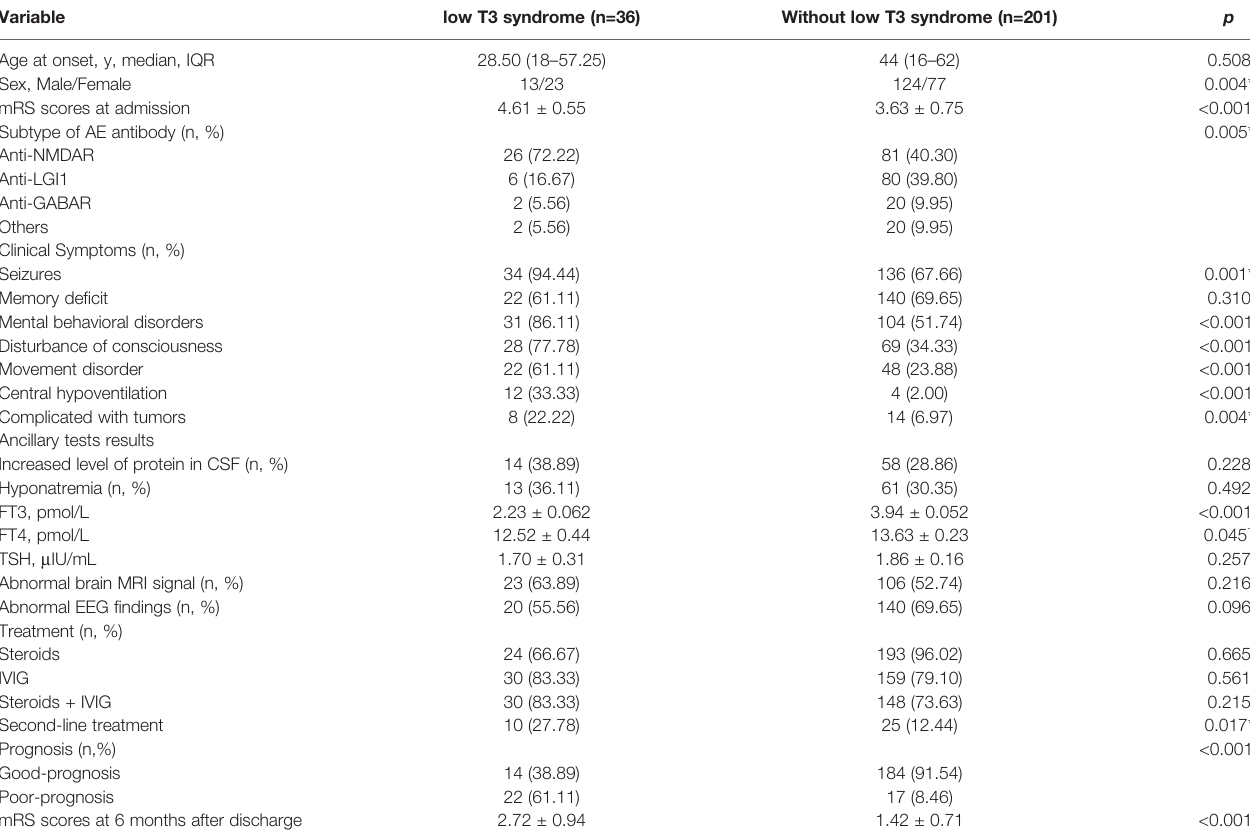
TABLE 2 | Clinical characteristics of patients with autoimmune encephalitis with or without low T3 syndrome.